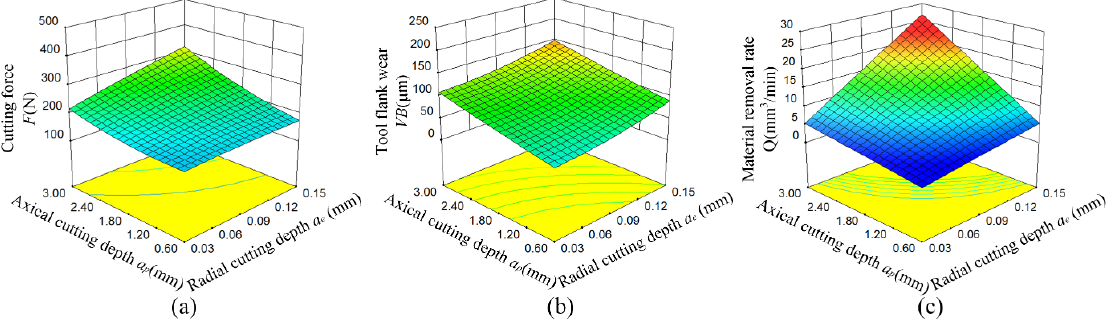
Figure 5. Response surface of radial depth of cut and axial depth of cut on cutting force, tool flank wear and material removal rate. ( a ) Cutting force F , ( b ) Tool flank wear VB , ( c ) Material removal rate Q .